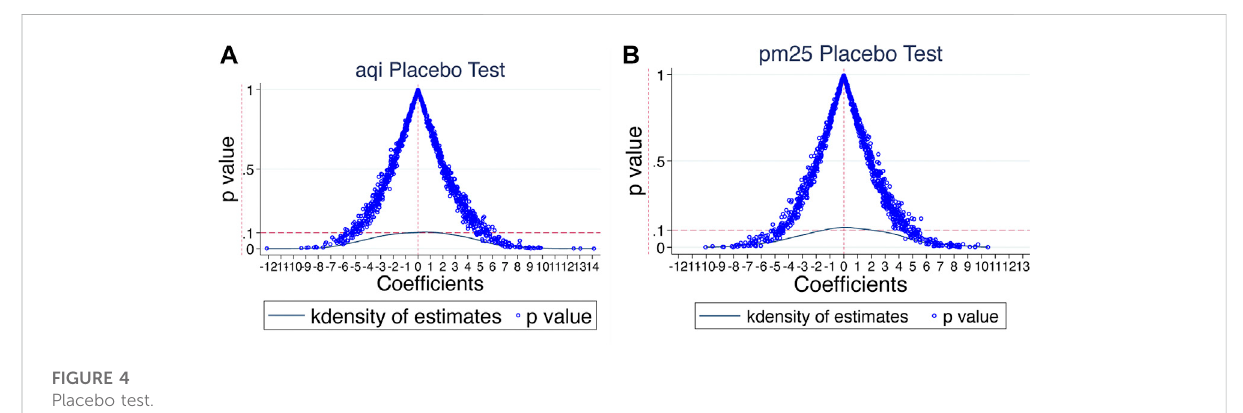
FIGURE 4 Placebo